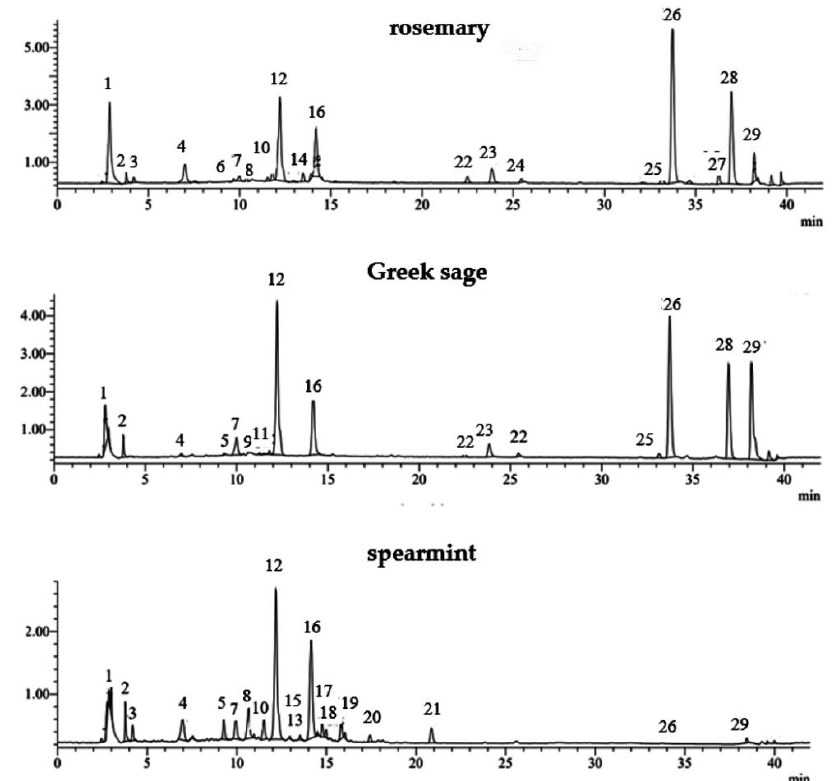
Figure 2. Mass chromatograms recorded in the negative ion mode for methanolic extracts from distillation residues of rosemary, Greek sage and spearmint, after the recovery of essential oil by steam distillation (SD). (1: quinic acid; 2: citric acid; 3: danshensu; 4: gallocatechin isomer; 5: luteolin-7- O -